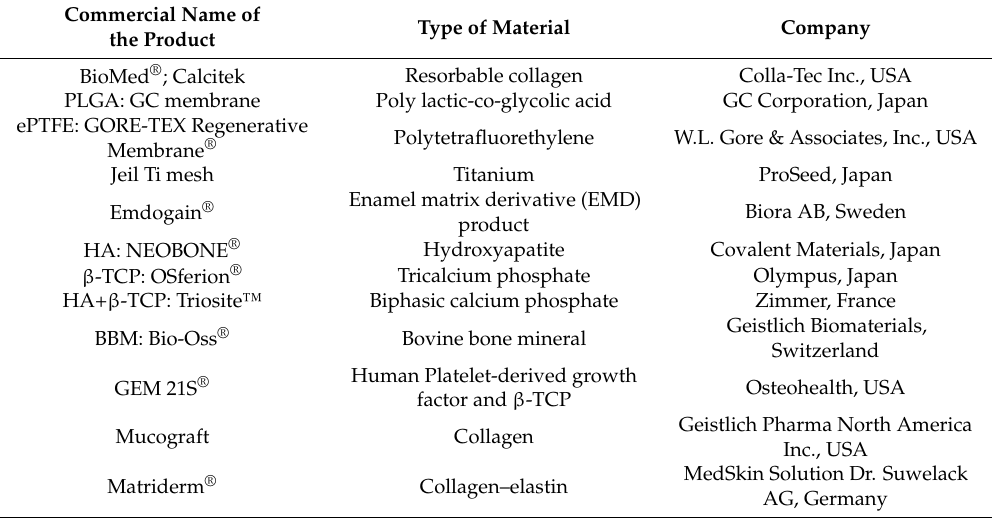
Materials used for conventional periodontal regenerative therapy [128] and as growth-factor-based grafts for dental surgical procedures